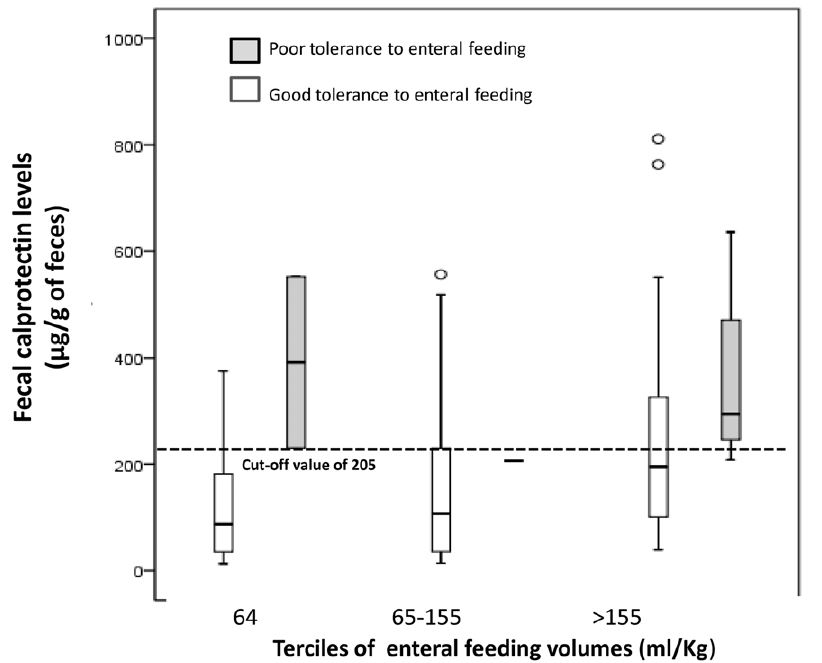
Figure 3. Fecal calprotectin as a function of the tercile of enteral feeding volume and tolerance to enteral feeding. The median and interquartile range of fecal calprotectin are plotted for each volume of enteral feeding in infants with good (open boxes) or poor (closed boxes) tolerance to feeding. Poor tolerance to feeding was defined as the need for unplanned enteral feeding interruption.